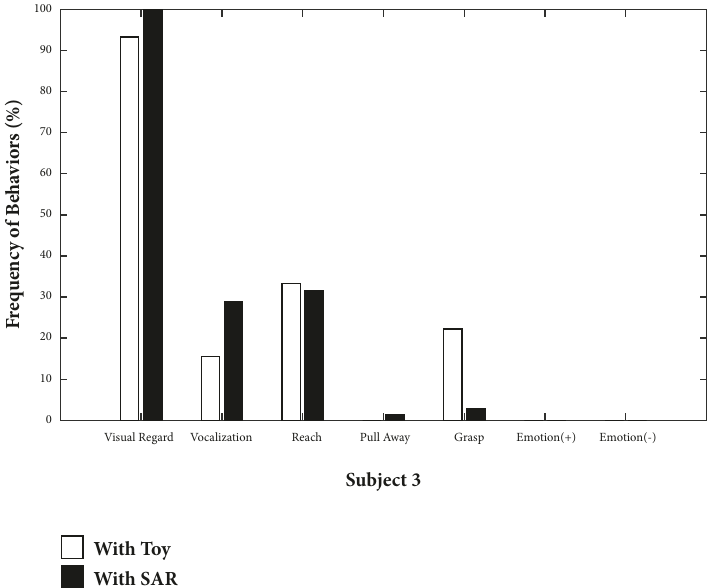
Figure 7: Results for Subject 3, which show a higher level of interaction with the SAR over the switch-adapted toy when considering the primary behaviors of Visual Regard, Vocalization, and Gross Motor